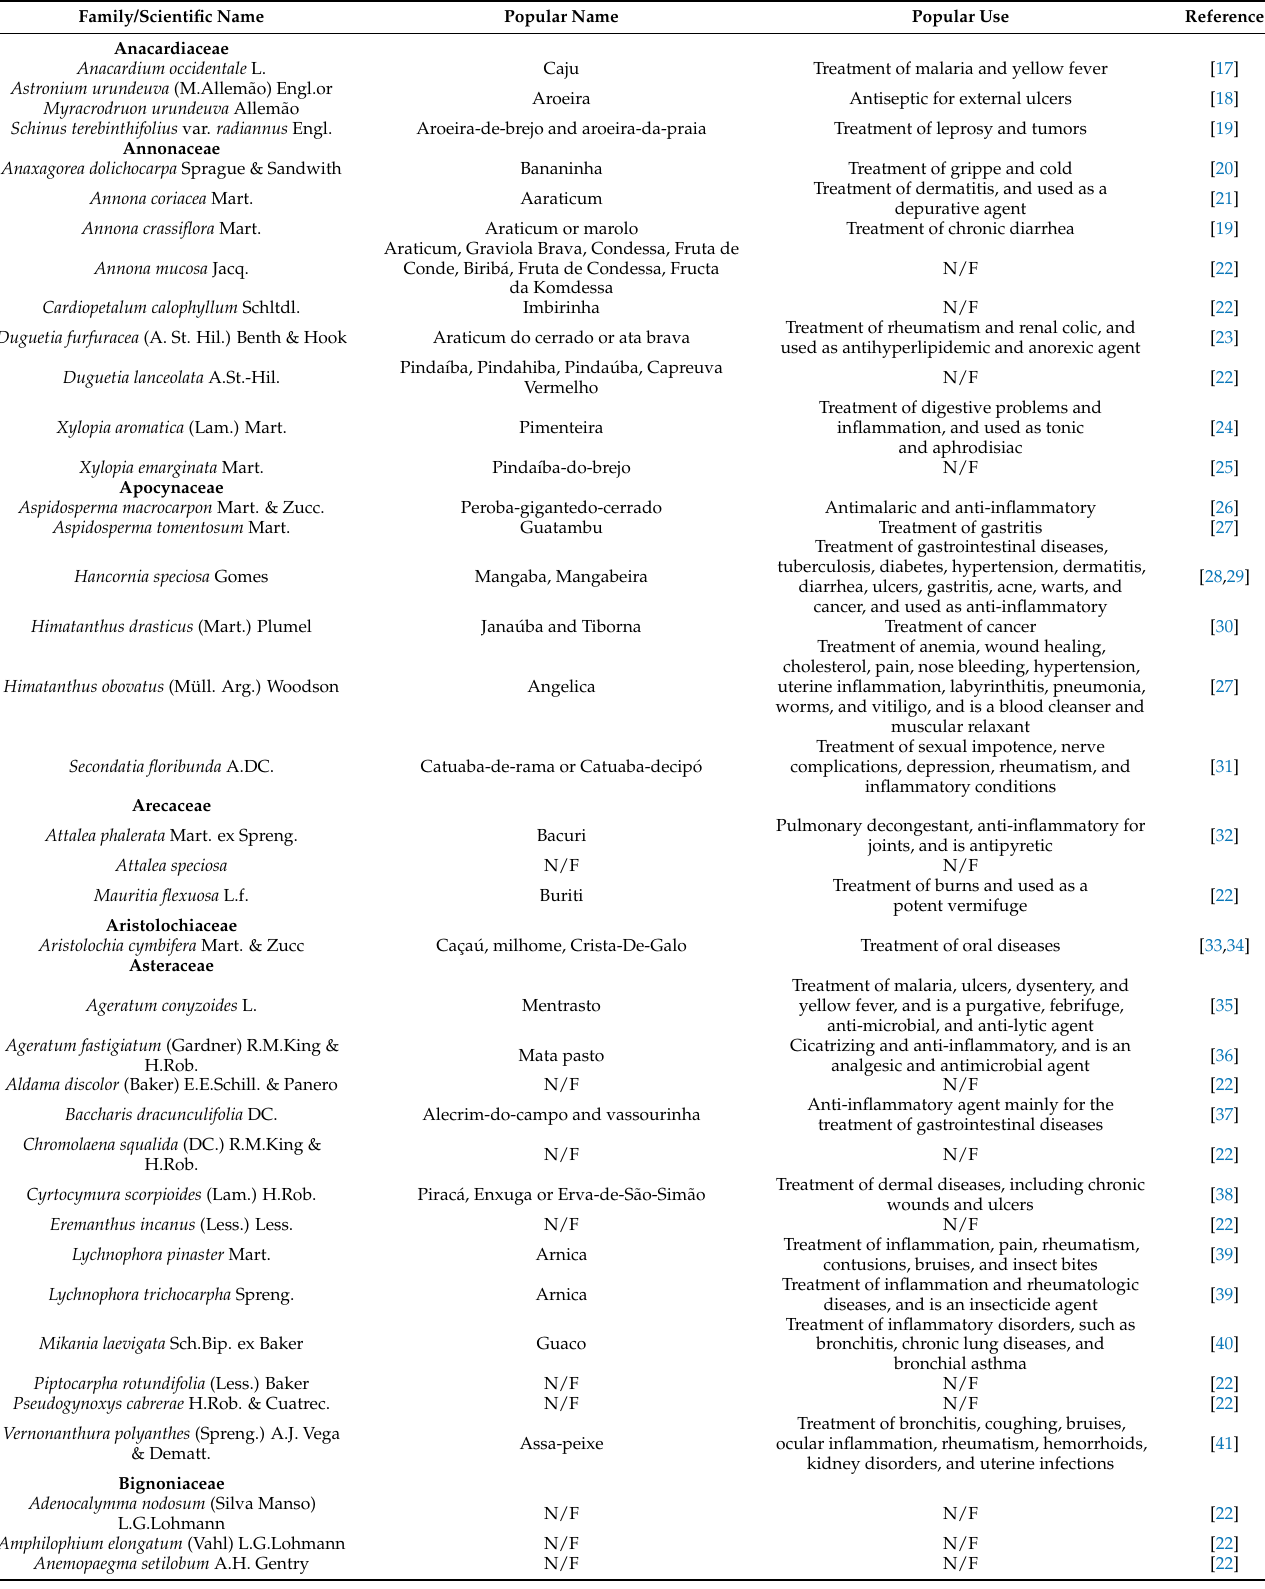
Table 1. Ethnobotanical data for the Cerrado biome plant species included in the present